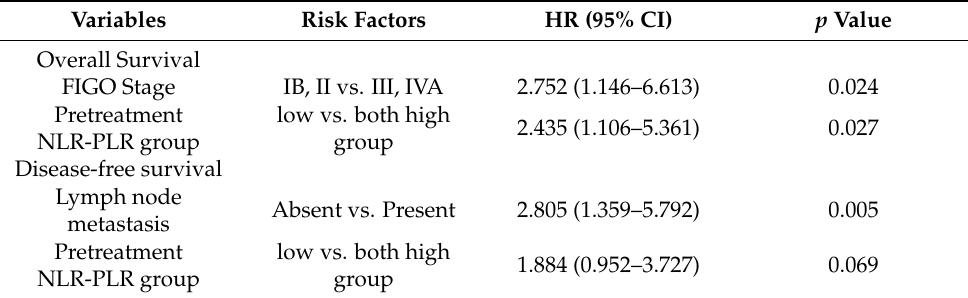
Table 4. Multivariate survival